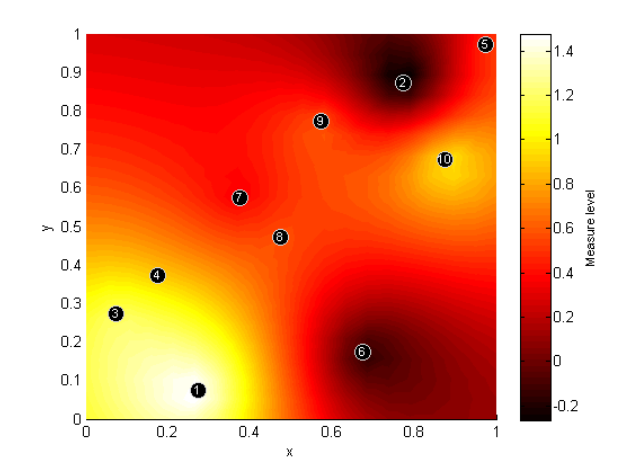
Fig. 6. Initial grid with 10 mobile